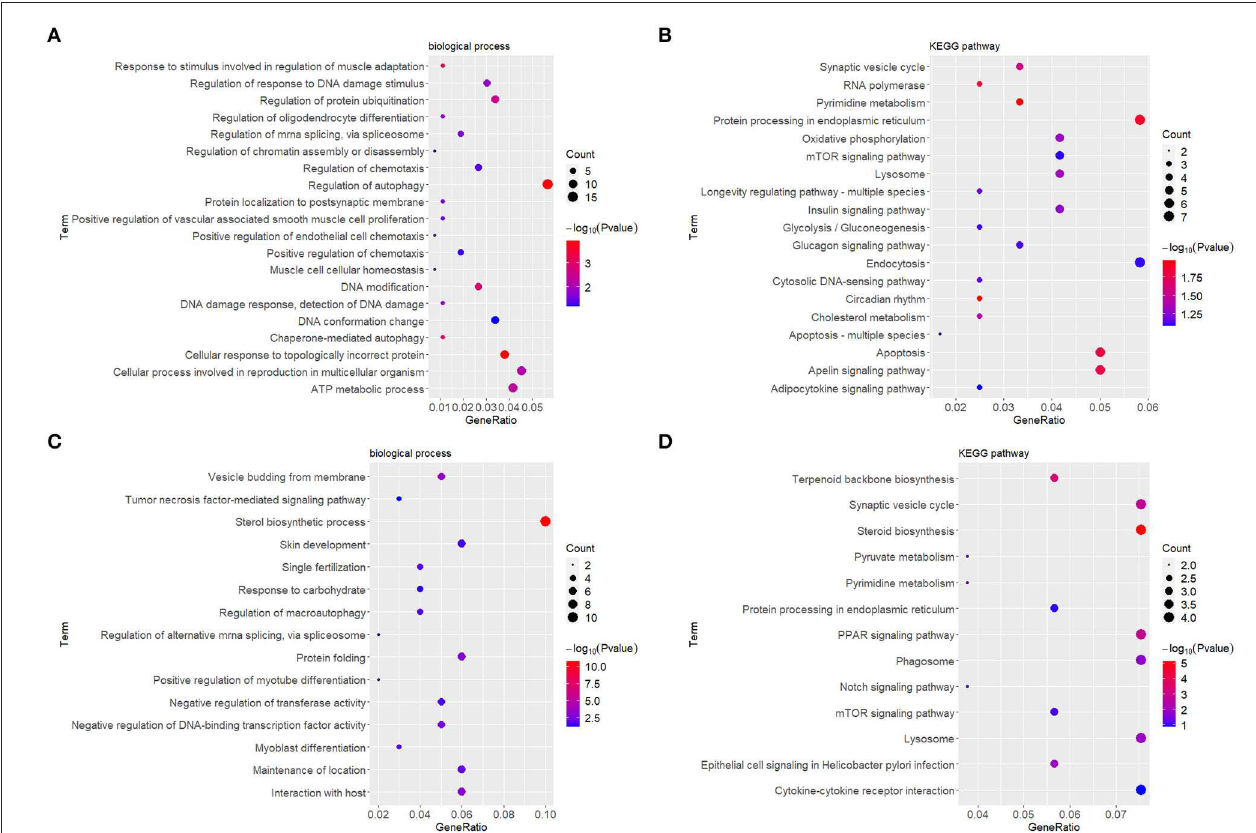
FIGURE 4 | GO enrichment and KEGG analyses showed changes in the molecular response and signaling pathway of HDFs under mechanical stretch. (A) GO enrichment analysis of the DEGs at 5h and (B) at 24h. (C) KEGG analysis of the DEGs at 5h and (D) at 24h. The gene ratio indicates the number of DEGs associated with the GO term divided by the total number of DEGs. The size of the dots represents the number of DEGs associated with the GO term, and the color represents the negative value of log 10 of p value. GO, Gene Ontology; KEGG, Kyoto Encyclopedia of Genes and Genomes; HDFs, human dermal fibroblasts; DEGs, differentially expressed